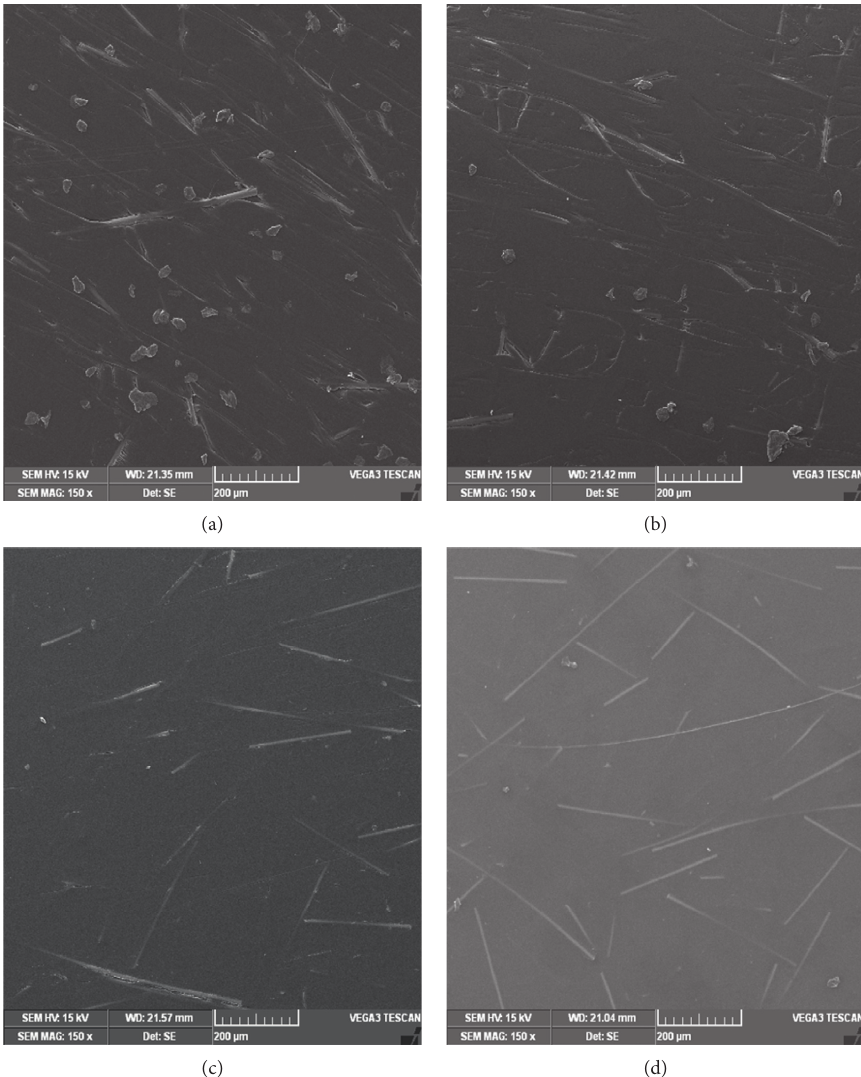
Figure 14: Microsurface images of GFRPP samples molded at different cavity surface temperatures immediately before filling: (a) CIM; (b) RHCM60; (c) RHCM90; (d)